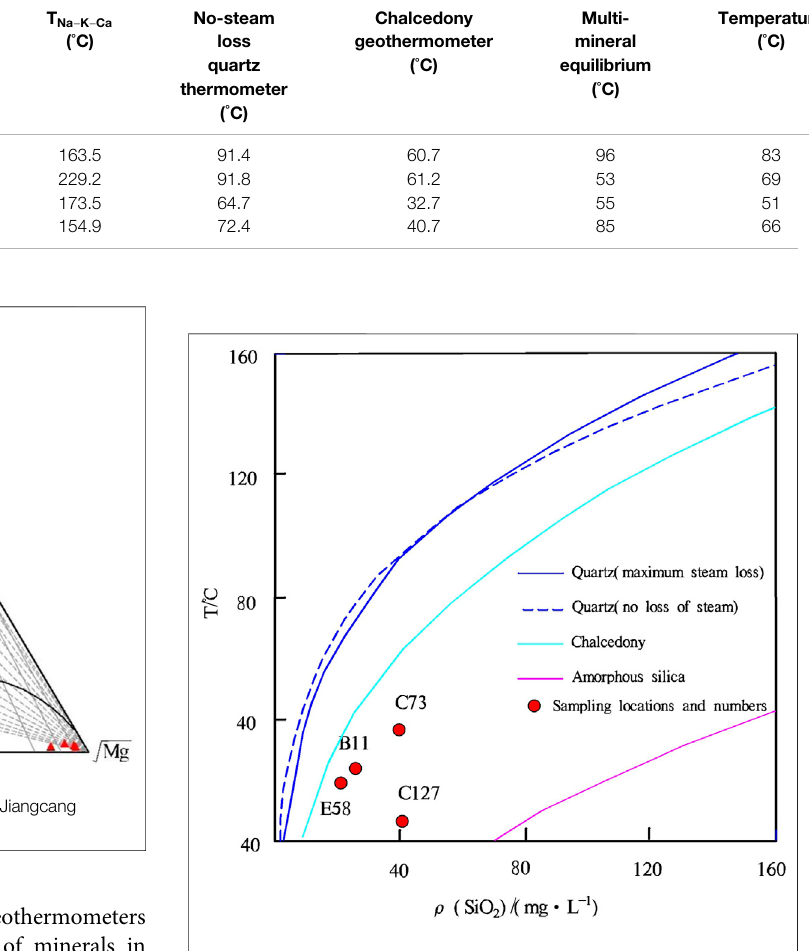
FIGURE 7 | Relationship between ρ (SiO 2 ) and